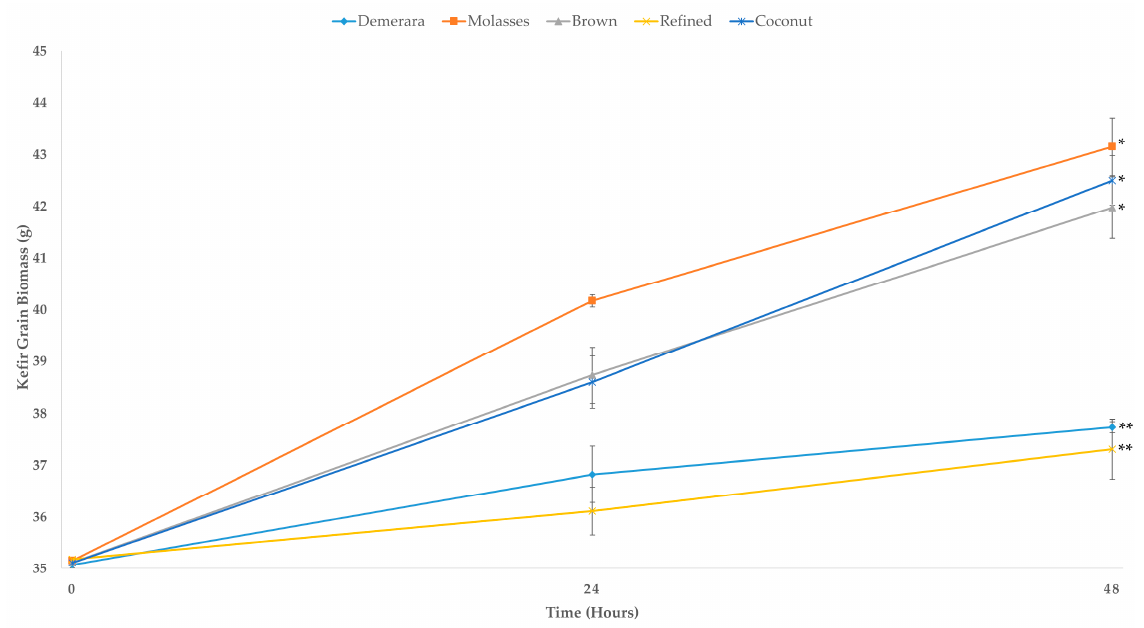
Figure 6. Biomass growth of water kefir grains during the fermentation process in different sugary substrates (Demerara, Molasses, Brown, Refined and Coconut). The asterisks indicate groups without a statistical difference (* or **) according to the Tukey test performed for the results at 48 h.